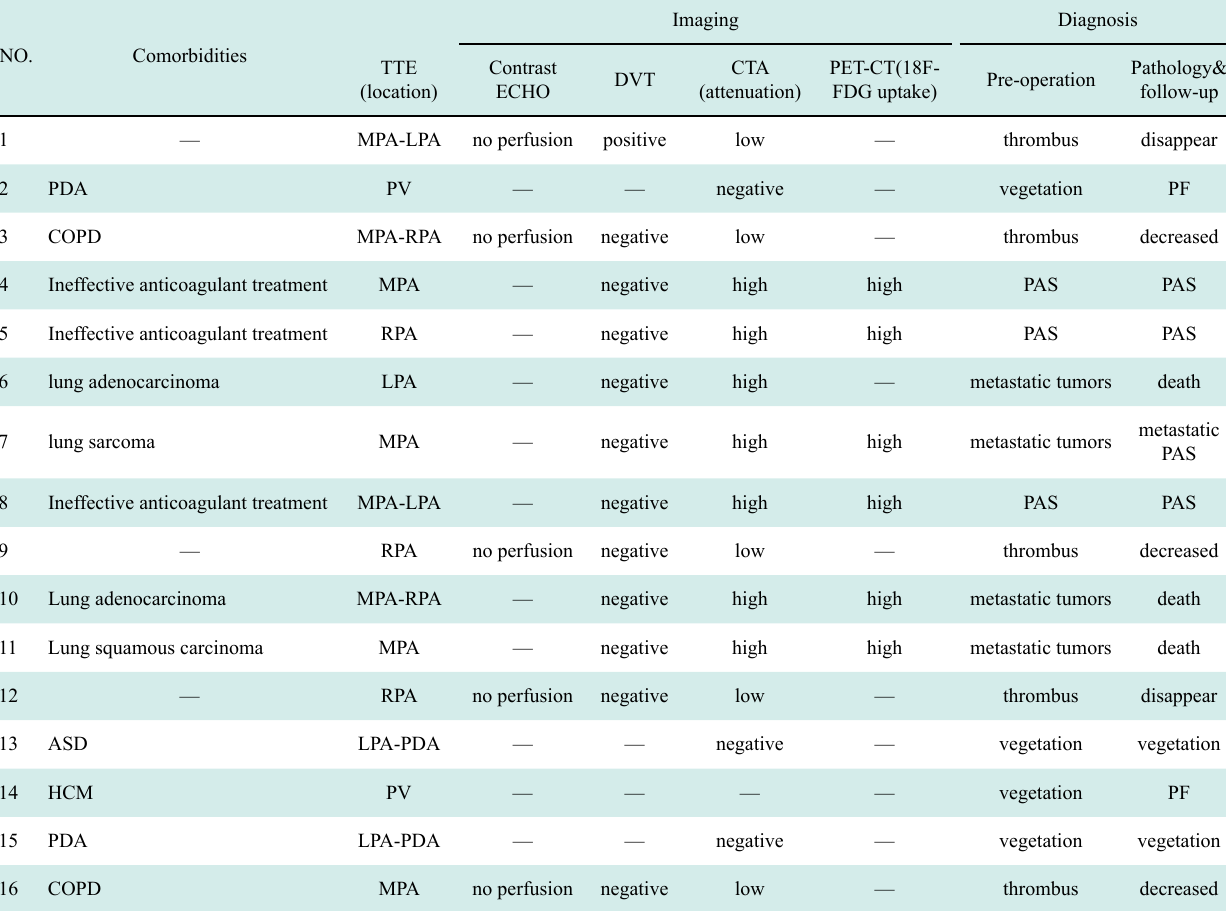
Table 1 Characteristics of the 16 adult patients with an intrapulmonary artery mass